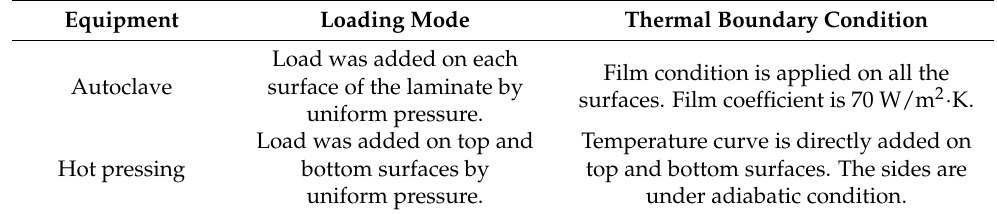
Table 5. Different settings of the cure process in autoclave and hot pressing in FE models.